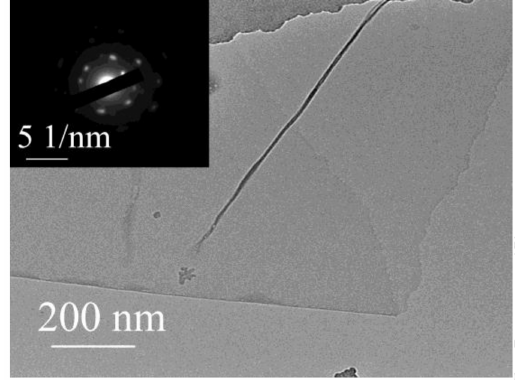
Figure 4. TEM image (EDS of inset) of r-GO H